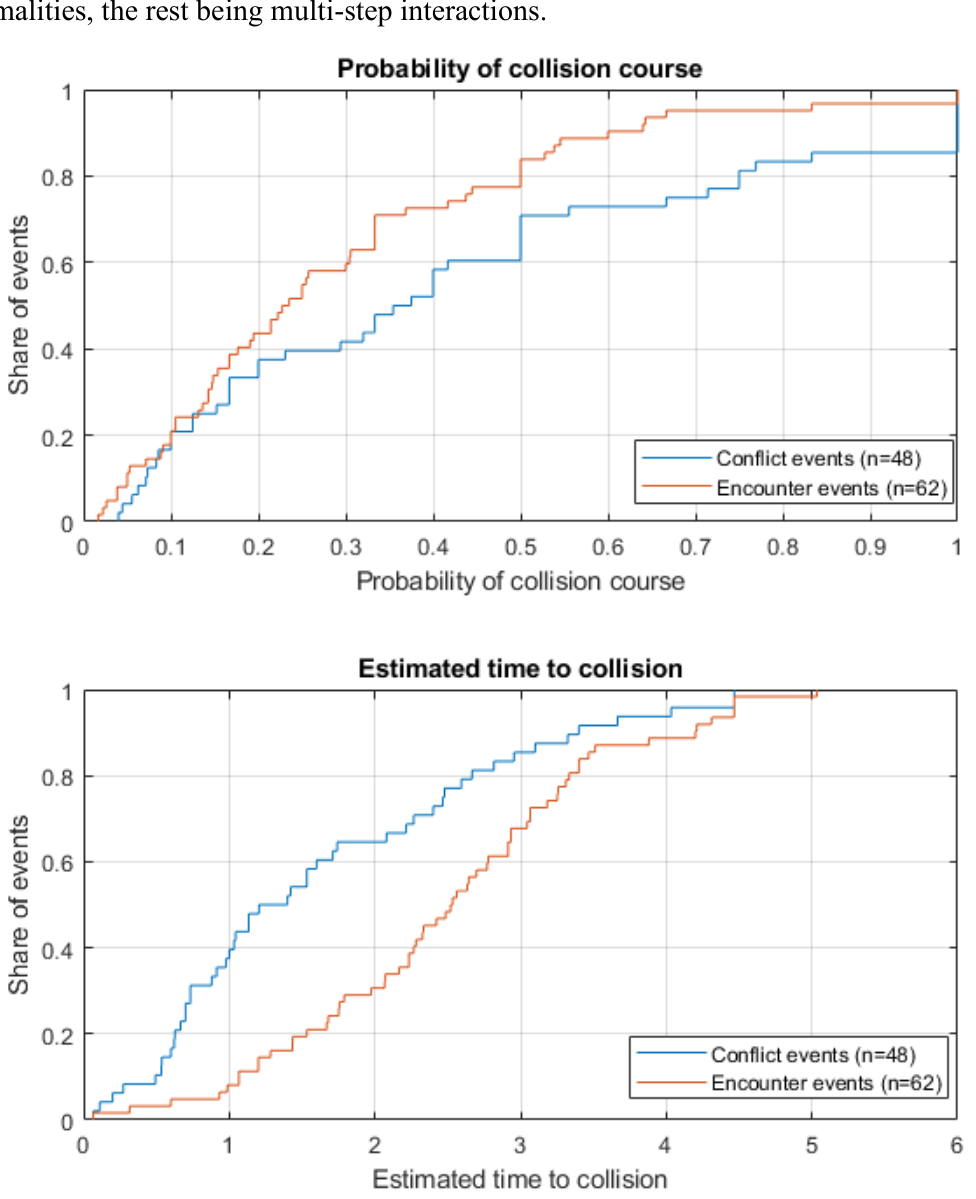
Figure 10 The cumulative frequency distribution of the probability of collision course (PCC) and the probabilistic Time-to-Accident (TA) for the events in Category